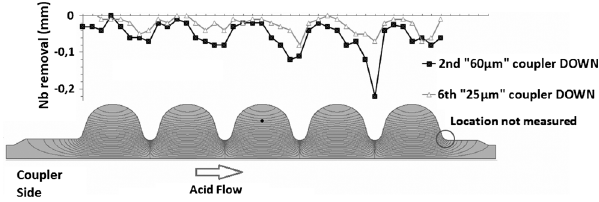
FIG. 12. Niobium removal during two different VEP sequences with the same cavity orientation. The removal in the upper cells is dramatic if hydrogen is not properly evacuated (black curve).